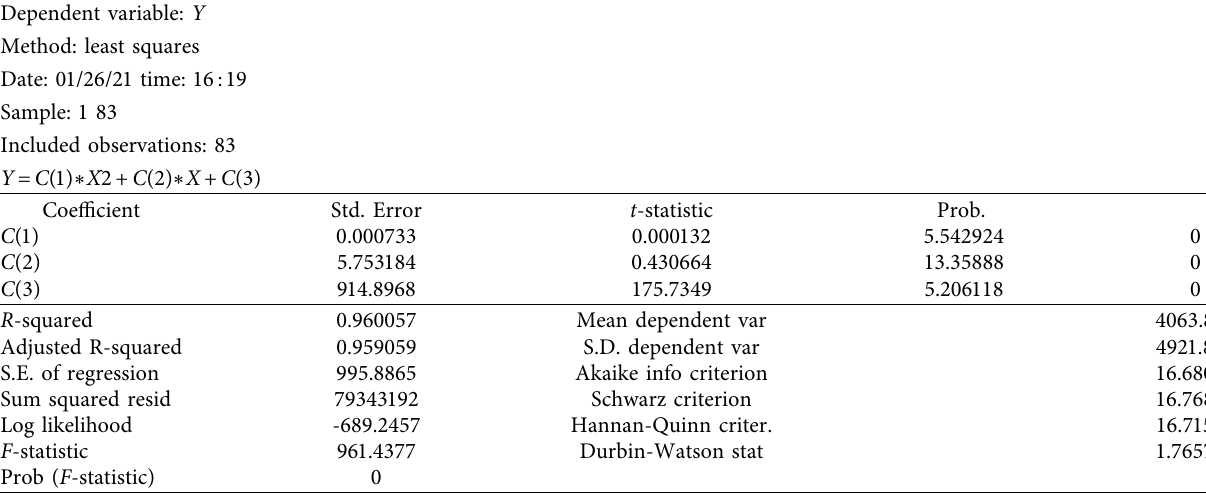
Table 6: Quadratic function regression results of road transportation economic cost.